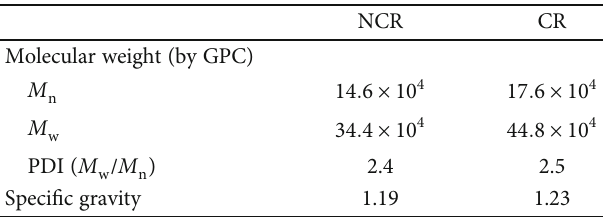
Table 2: Molecular weight and speci fi c gravity of acrylonitrile- chloroprene rubber (NCR) and chloroprene rubber